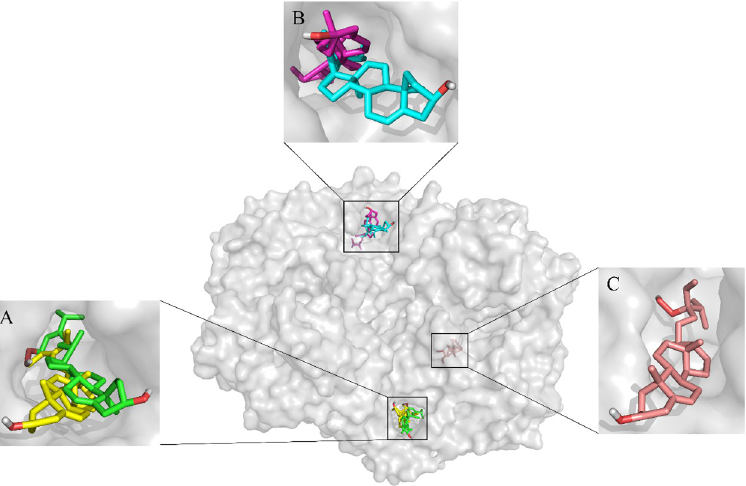
Fig 4. Molecular docking of COX-1 with compounds 1–5. Different compounds were located in different active pockets. Compounds 1 and 4 were located in the hydrophobic pocket A of COX-1 (Comp. 1 shown in green, Comp.4 shown in yellow), compounds 2 and 3 were located in the pocket B of COX-1 (Comp.2 shown in cyan, Comp.3 shown in magenta), while compound 5 was located in the pocket C (Comp.5 shown in salmon).